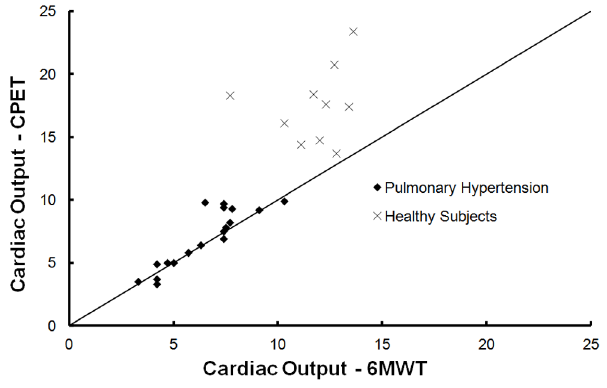
Figure 2. Cardiac output measured at rest, after 3 minutes of unloaded cycling and at directly after the end of maximal CPET in 18 pulmonary hypertension patients (stripped line) and 10 healthy subjects (solid line).